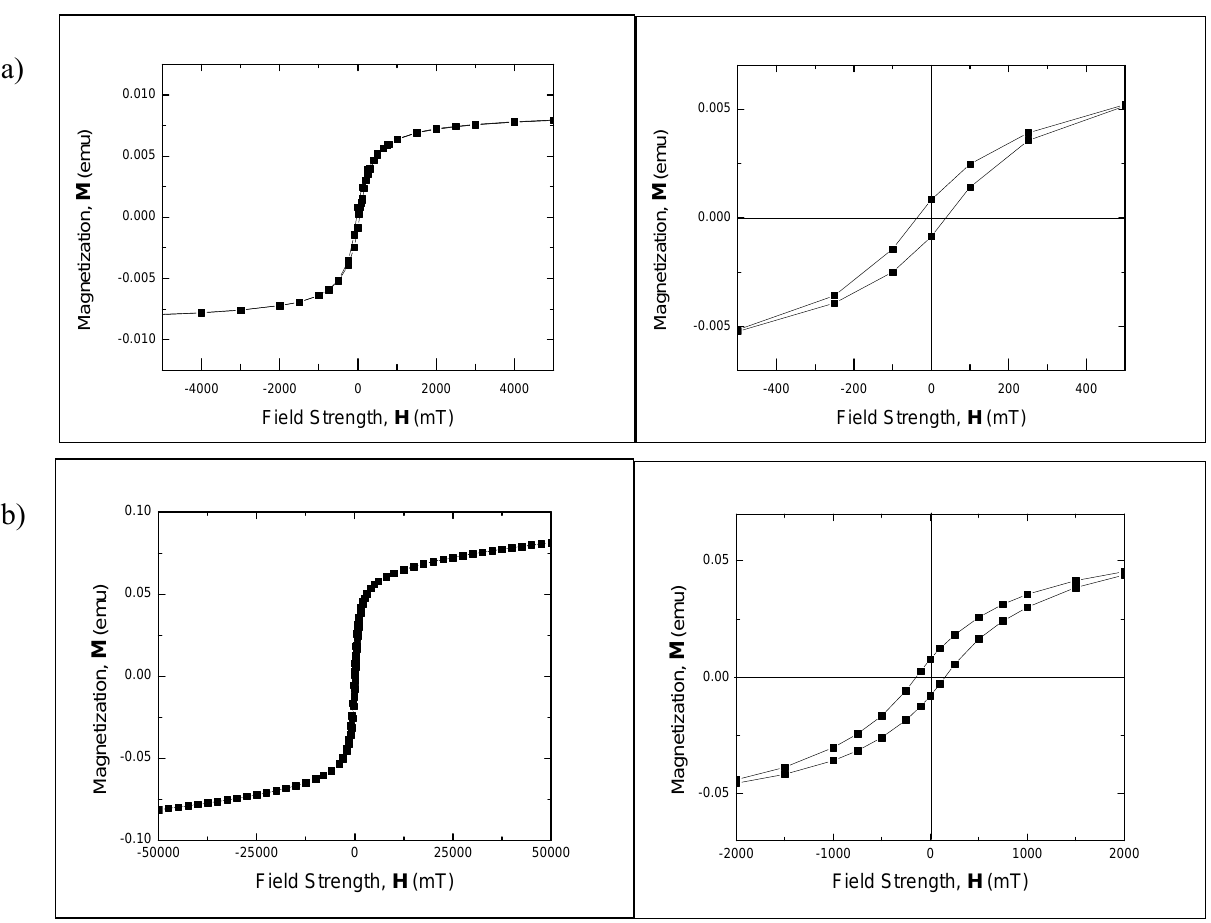
Figure 6. Hysteresis loop for ( a ) Fe O polymorphous nanocrystals and ( b ) ~22 nm Fe 3 4 = 100 s. Left : full sweep of magnetic field measured at 293 K showing nanospheres. τ m saturation. Right : enlarged loop measured at 293K at low